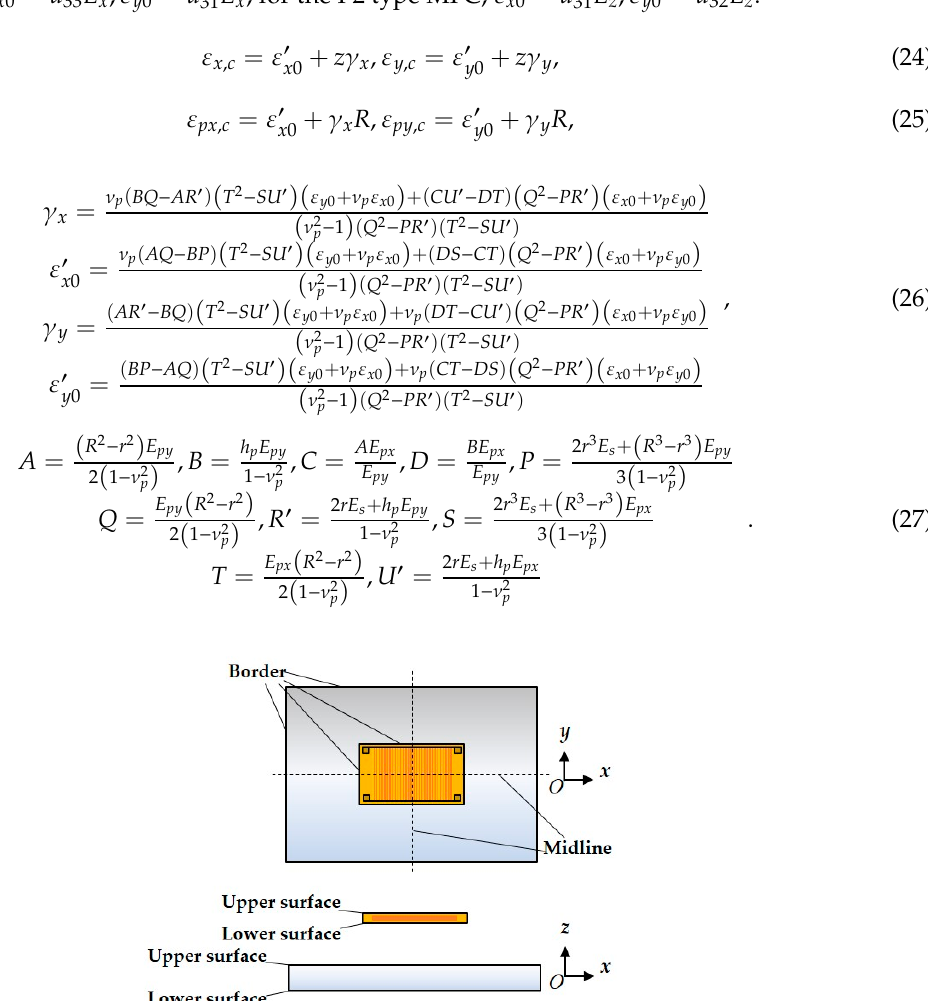
Figure 3. Boundary position of the MFC laminated plate.